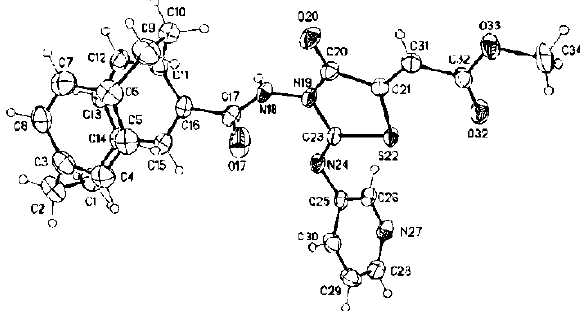
Figure 7. Molecular structure of compound 3b identified according to IUPAC nomenclature as methyl ( E )-2-(( E )-2-(2-(1,4(1,4)-dibenzen-cyclohexaphane-12-carbonyl)hydrazinylidene)-3-benzyl-4- oxothiazolidin-5-ylidene)acetate.